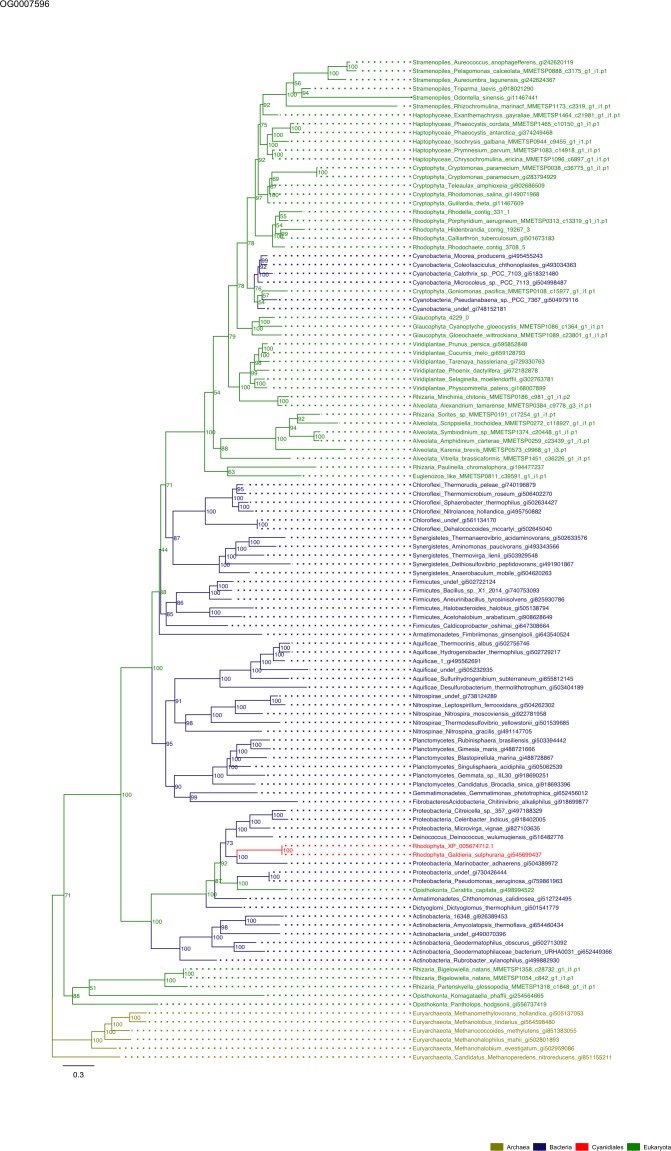
Sequence tree of orthogroup OG0007596.The tree is based on amino acid sequences. Archaea (yellow), Bacteria (blue), Cyanidiales (red), Eukaryotes including other red algae (green). Branches containing Cyanidiales sequences are highlited in red.